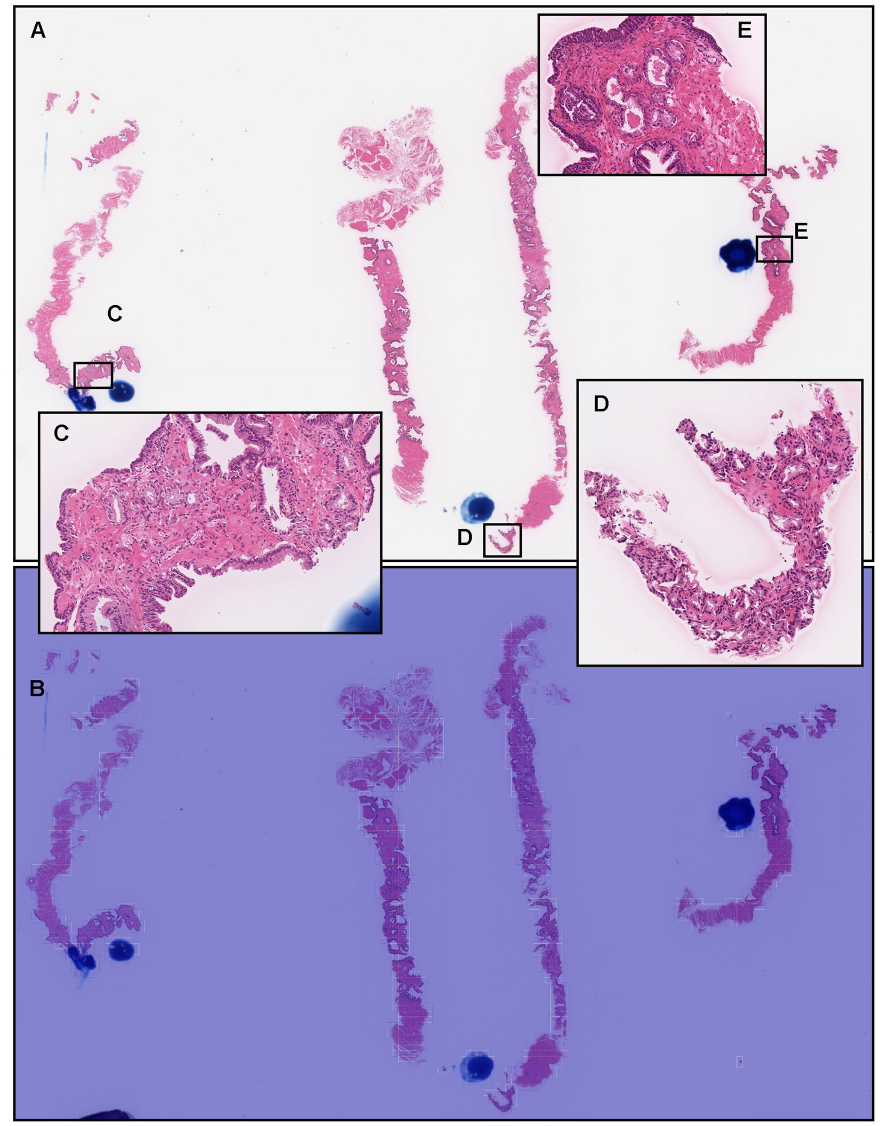
Figure 5. Representative false negative prostate adenocarcinoma from the needle biopsy test sets. According to the histopathological report, there were four needle biopsy specimens in the WSI, and three of them had adenocarcinomas ( A ). The pathologists marked the adenocarcinoma areas in blue dots ( A ). High-power view showing that there were adenocarcinoma foci ( C – E ). The heat map image ( B ) shows no true positive predictions of adenocarcinoma using transfer learning from the colon poorly differentiated adenocarcinoma model (TL-colon poorly ADC-2 (20 × ,